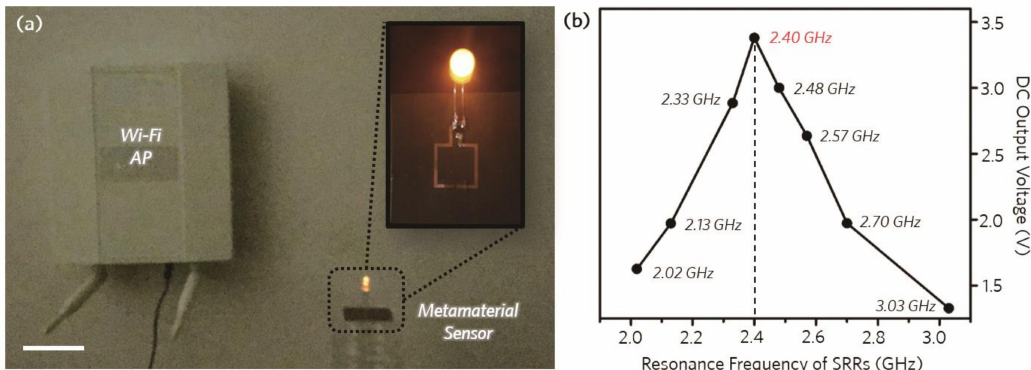
Figure 5. Wi-Fi energy-harvesting sensor system. ( a ) Photograph of the experimental setup for the Wi-Fi energy-harvesting sensor sys-tem. The inset shows the energy-harvesting sensor connected to an LED. (scale bar: 5 cm) ( b ) Measured DC output voltage of the Wi-Fi harvesting metamaterials with different resonance